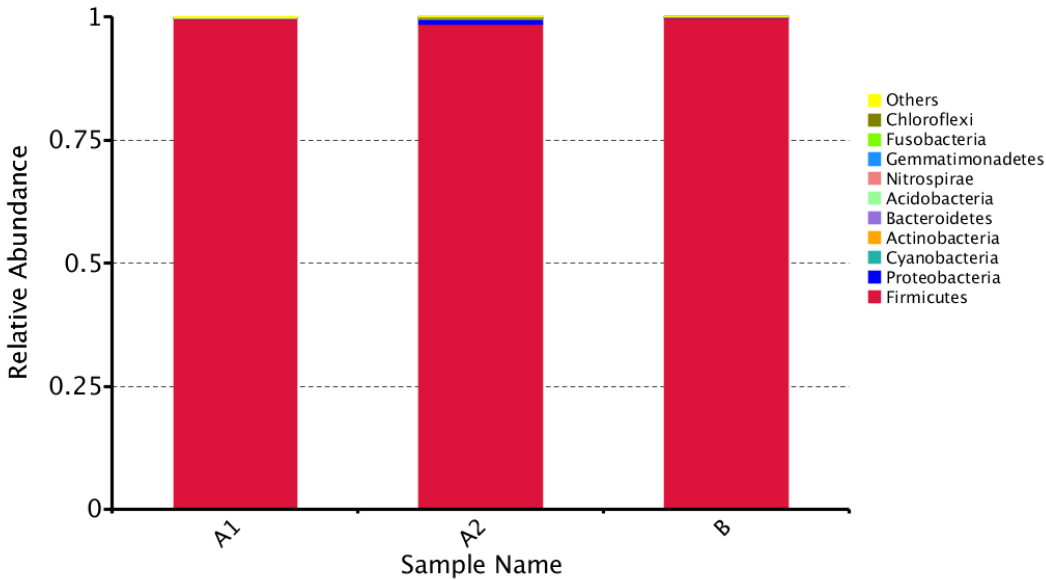
Figure 4. The relative abundance of the three extremely halophilic microbial samples associated with ten different phyla, showing the dominance of Firmicutes in all of the samples.